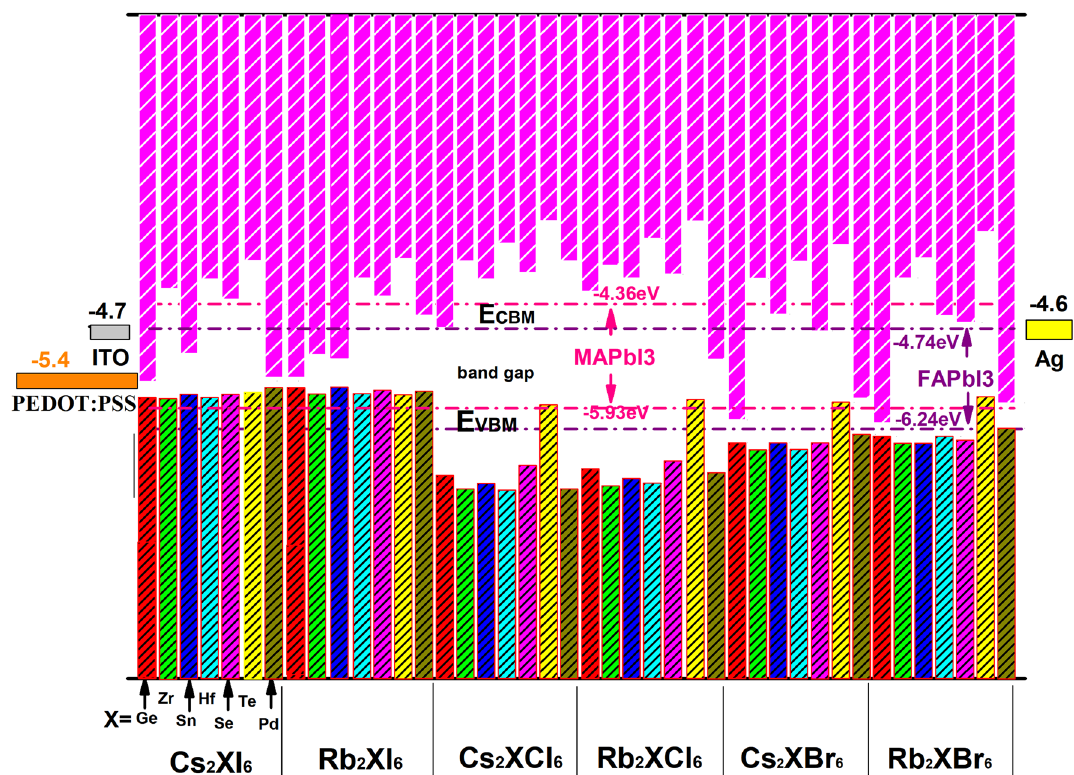
Figure 7. The valence band maxima (VBM) and conduction band minima (CBM) of 42 crystals, the energy band value of ITO, Ag and PEDOT:PSS is shown in Figure with unit (eV)